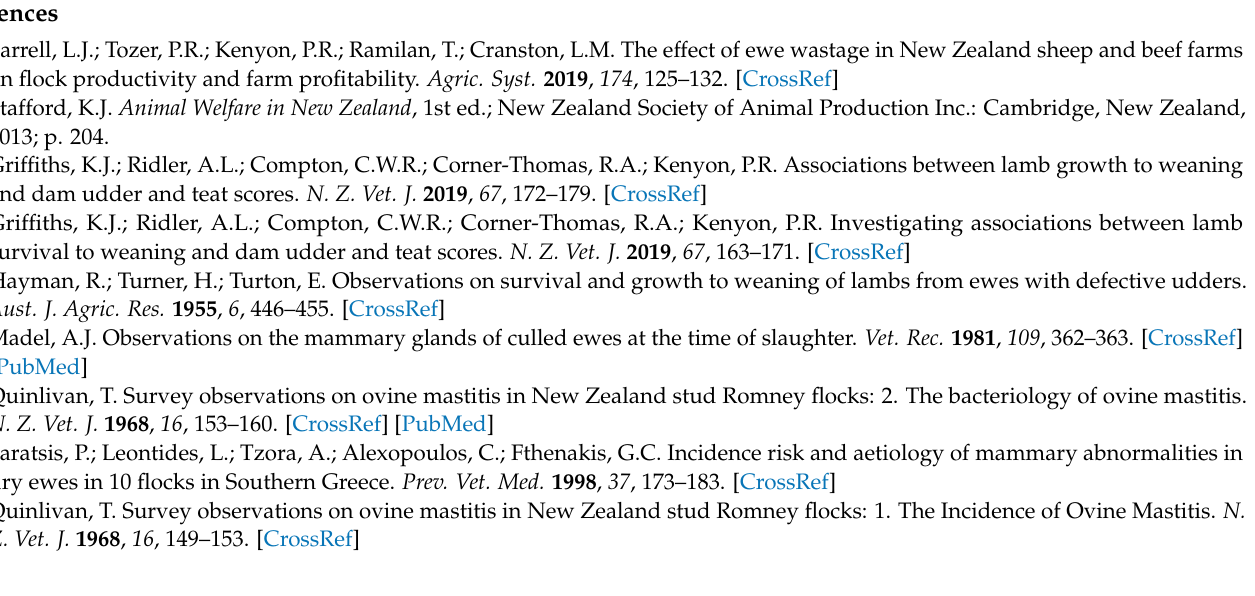
Figure A5. Lasagna plot of palpable udder half defects (hard, lump, and normal) in the first six weeks of lactation in non-dairy Romney ewes (Study B). Udder examination was undertaken at weekly intervals from 37 udder halves that did not express milk. Note: Within each plot, each bar shows a different udder scoring event (i.e., time) while the different colours within each bar represent the defect categories. The data in the table at the top of the plot designates the percentage of each udder half defect category at each event, which corresponds to the percentage of each colour at each event. Change in defect category over time of each udder half can be tracked by following longitudinal transitions across the udder scoring events of stacked bars. Note that an udder half that did not express milk refers to an udder half that did not express milk at all on at least four occasions and expressed less than 100 g/day on the other two occasions.